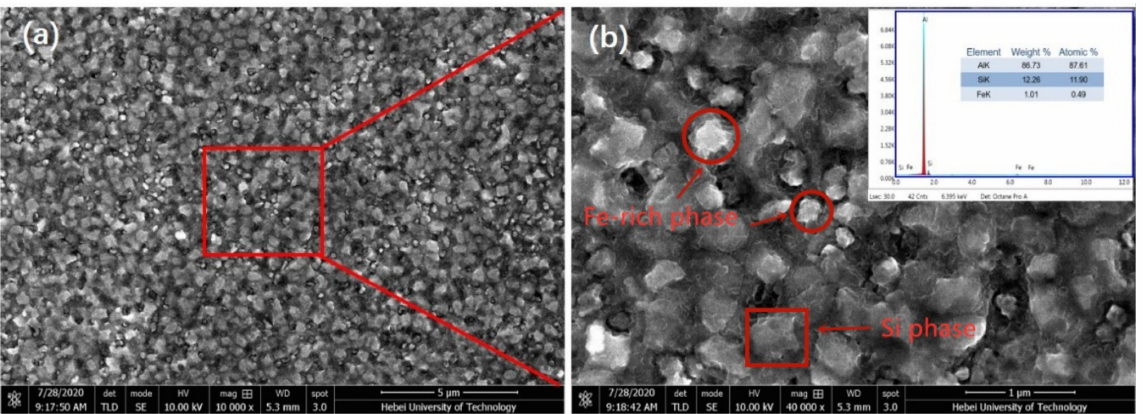
Figure 4. ( a ) SEM images of the C3 alloy. ( b ) is the magnification of the region in ( a ), while the inset is the EDS results of the region in ( a ).